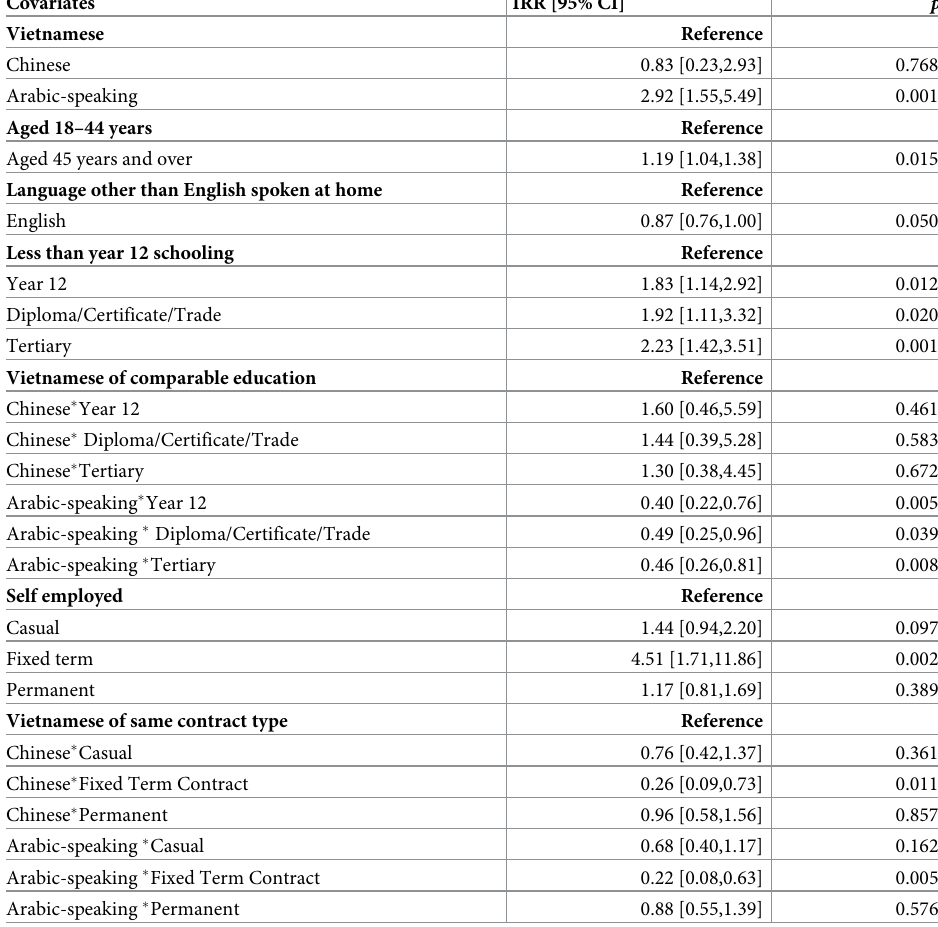
Table 4. Number of psychosocial stressors# 0 to 6 (bullied, ethnic discrimination, complexity, control, security and unfair pay), among migrant workers with interactions. Covariates IRR [95% CI] p Vietnamese